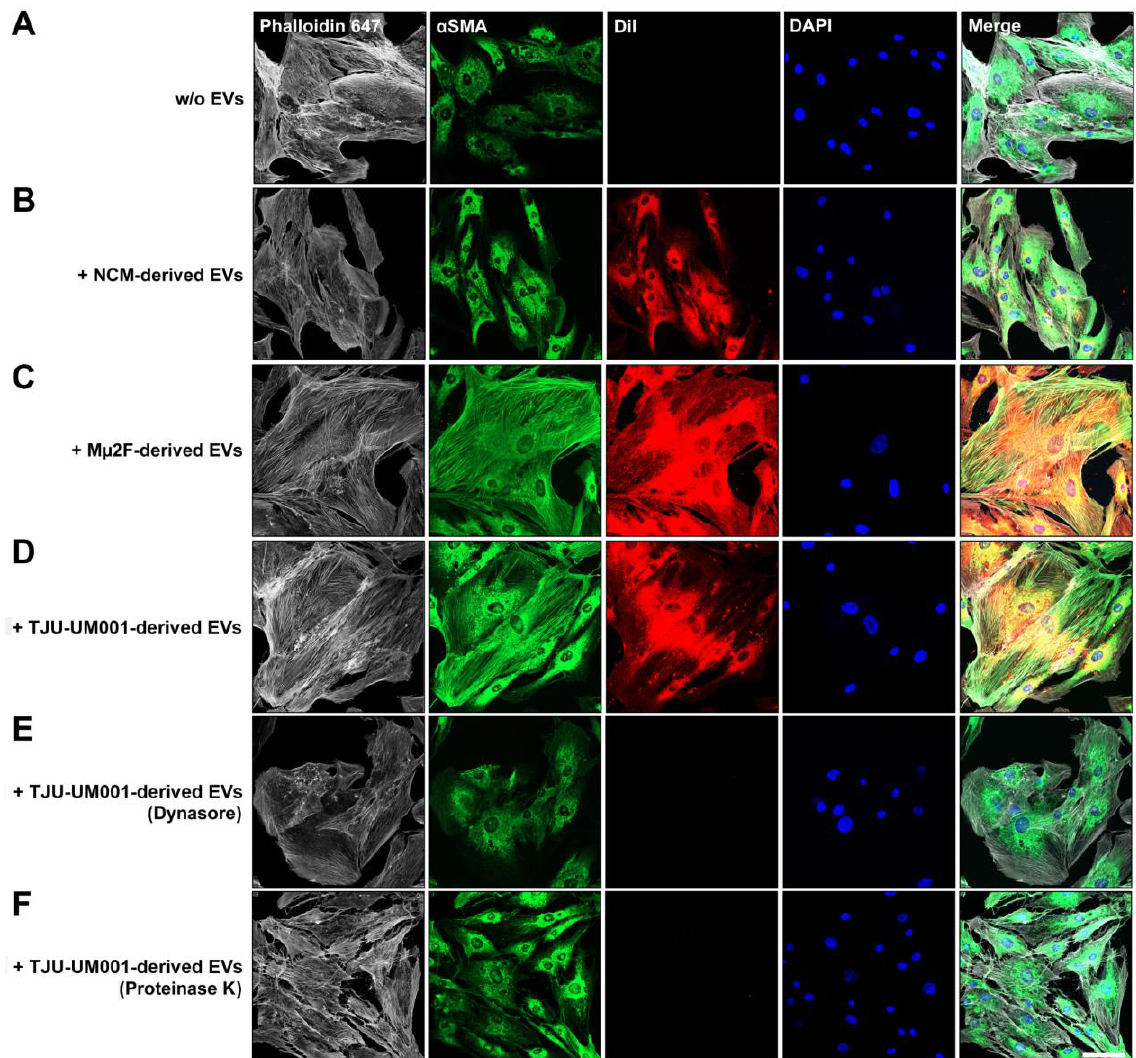
Figure 5. Activation of stellate cells after the internalization of UM-derived EVs. ( A ) The expression of F-actin (Phalloidin 647; grey) and α -SMA (green) was assessed in HSteCs without addition of EVs by confocal microscopy. Nuclei were counterstained with DAPI (blue). ( B ) Large EVs isolated from NCMs (normal cell control) or ( C ) metastatic UM cell lines Mµ2F and ( D – F ) TJU-UM001 were labeled with DiI (red) and added to HSteCs for 24 h to allow for their uptake before observing the expression of F-actin (grey) and α -SMA (green). ( E ) HSteCs were pretreated with Dynasore, or ( F ) TJU-UM001-EVs were pretreated with proteinase as controls. Scale bar, 50 µm.